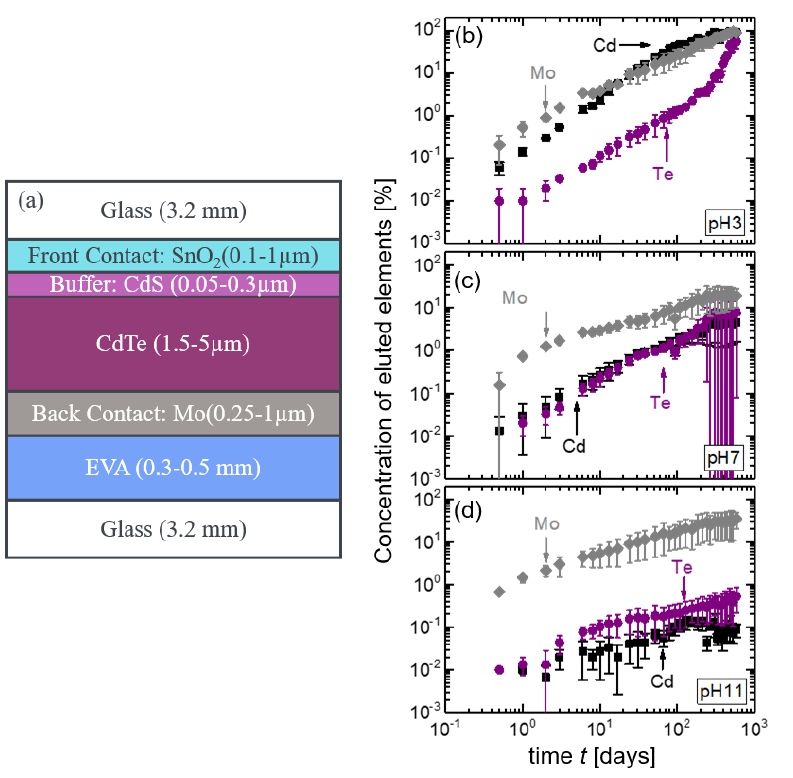
Figure 6. ( a ) Schematic structure of a typical CdTe module (not drawn to scale) and ( b ) time- dependent leaching results of the elements Cd, Te, and Mo from CdTe module pieces in acidic aqueous solutions with pH 3 and ( c ) in solutions with pH 7 and ( d ) pH